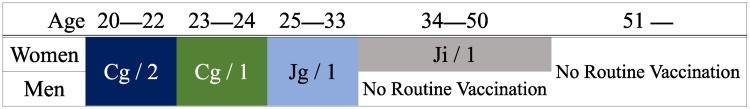
Transition of the national routine vaccination programs in Japan [10].The numbers in the upper row indicate the ages of persons in April 2013. (Cg/2) Those who received the two-dose group vaccination when they were children. (Cg/1) Those who received the single-dose group vaccination when they were children. (Jg/1) Those who received the single-dose group vaccination when they were junior high school students. (Ji/1) Those who received the single-dose individual vaccination when they were junior high school students. Men aged over 34 years were unvaccinated in the national vaccination program.